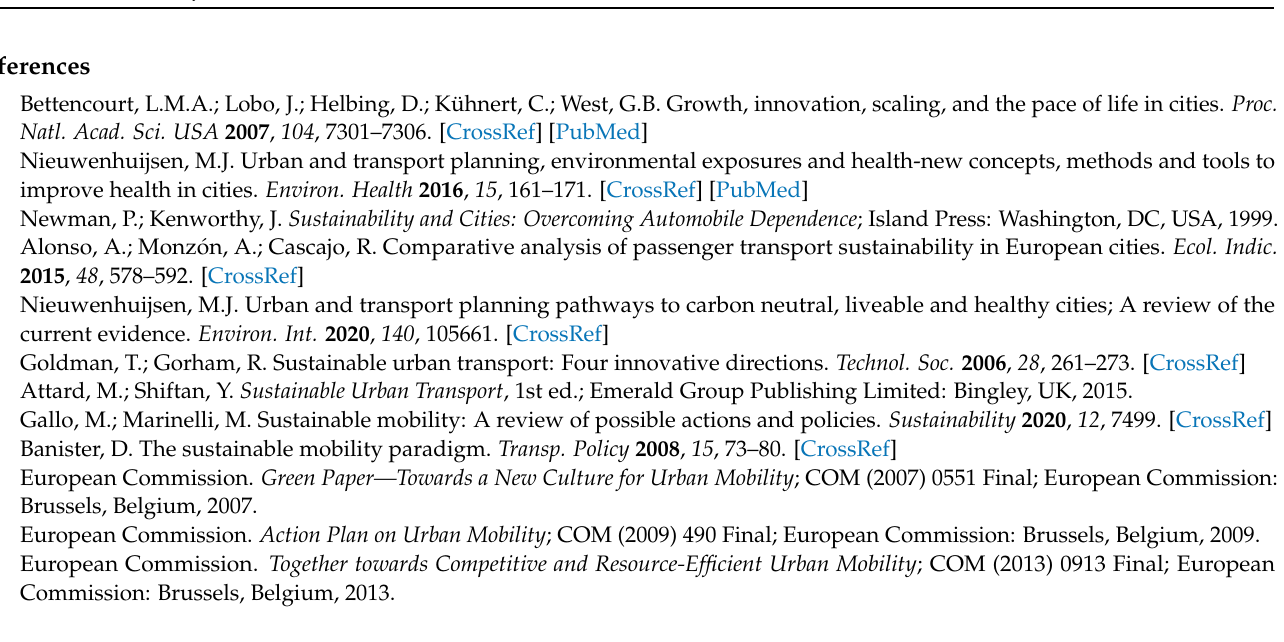
Cluster Error F